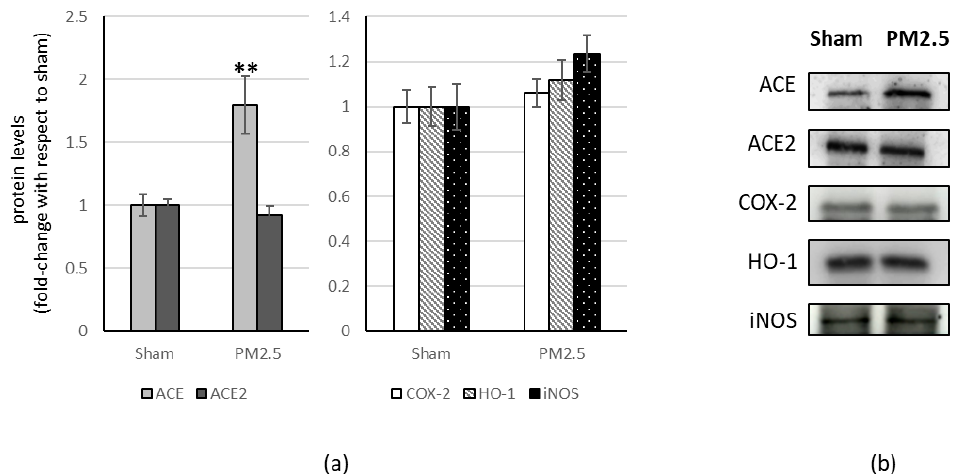
Figure 4. Immunoblotting analysis of ACE, ACE2, and COX-2, HO-1, iNOS in the liver. ( a ) Proteins were evaluated following cell subacute treatment with PM2.5. Each protein has been normalized with respect to the total amount of proteins detected by Ponceau staining, allowing a straightforward correction for lane-to-lane variation. Each protein has been normalized onto the respective sham (n = 5). Values represent Mean ± SE. ** p < 0.01 versus sham ( b ) Corresponding representative immuno-blotting images. Table 1. ACE/ACE2 ratio in the various organs analyzed. Organ ACE/ACE2 ±S.E. p lung 0.82 ±0.087 heart 0.90 ±0.143 liver 1.83 ±0.187 *** brain 1.40 ±0.127 * Each ratio is expressed relative to the sham value. Values represent Mean ± SE. * p < 0.05 versus sham, *** p < 0.001 versus sham.